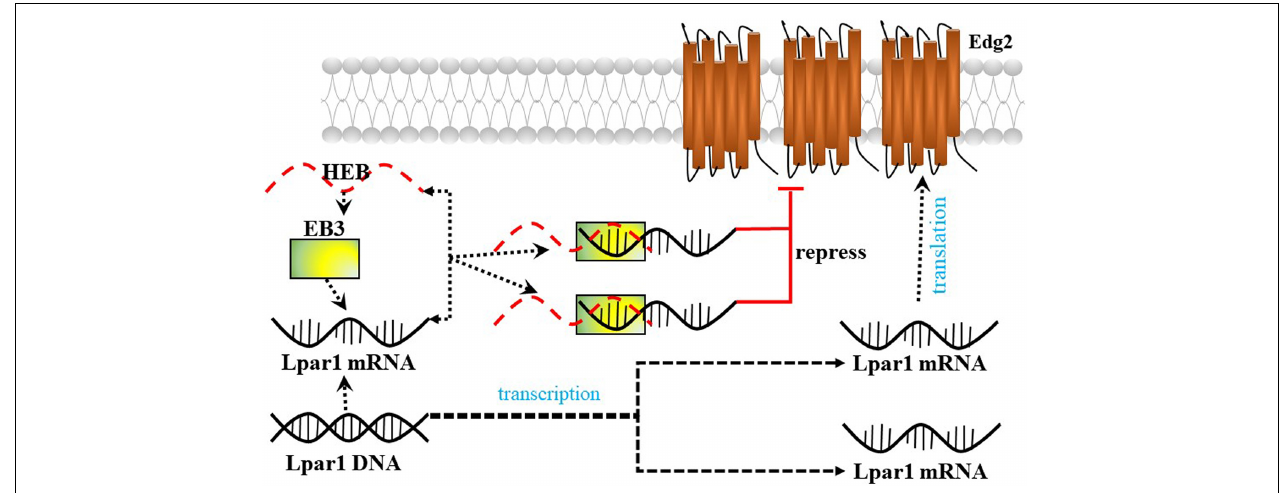
FIGURE 5 | The possible mechanism by which HEB repress